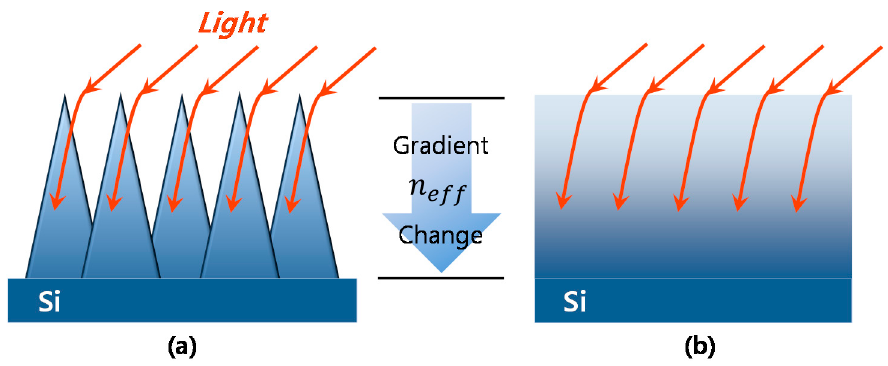
Figure 6. ( a ) Interaction of incident light with the Si NT array and ( b ) schematic illustration of the gradient refractive index change corresponding to ( a ).